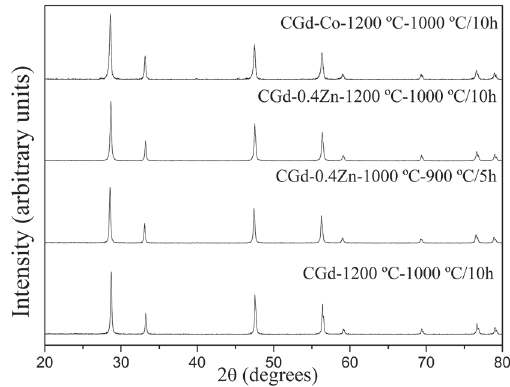
Figure 3: XRD diffractograms of the sintered samples.